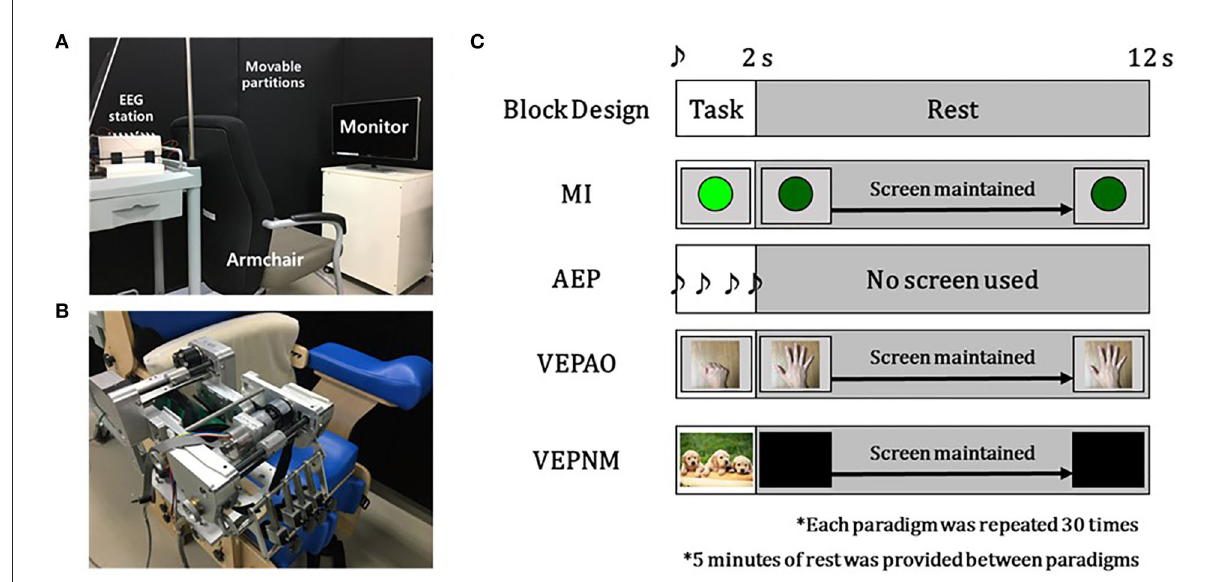
FIGURE3 Experiment setup and block design of the Paradigms. (A) Experiment setup for the measurement session. (B) Exoskeleton hand rehabilitation robot setup for the motor imagery-based brain–computer interface (MI-BCI) session. (C) Block design-based experiment paradigms. (VEPAO: VEP with action observation; VEPNM: non–motor-related VEP).